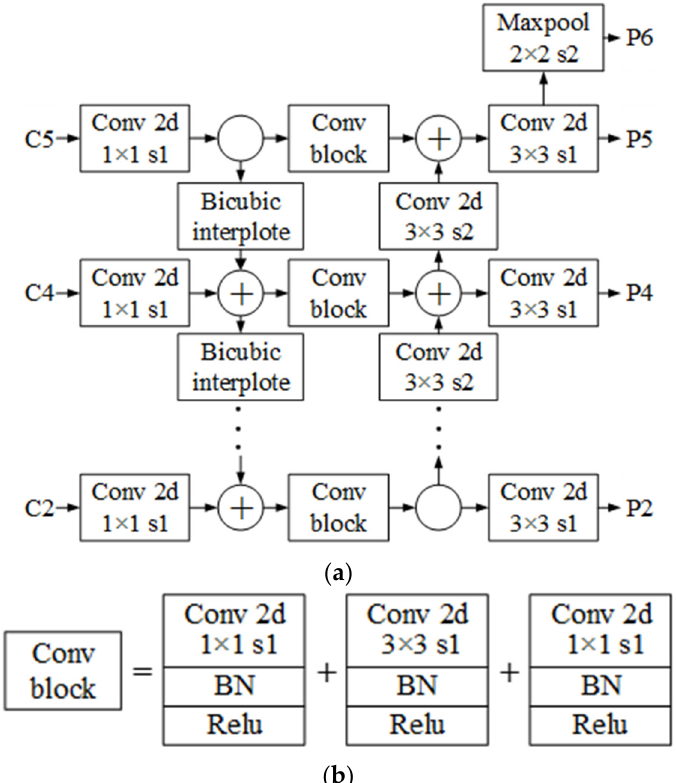
Figure 4. Schematic diagram of the I-PANet, ( a ) Structure of the I-PANet, ( b ) Structure of the “Conv block”.